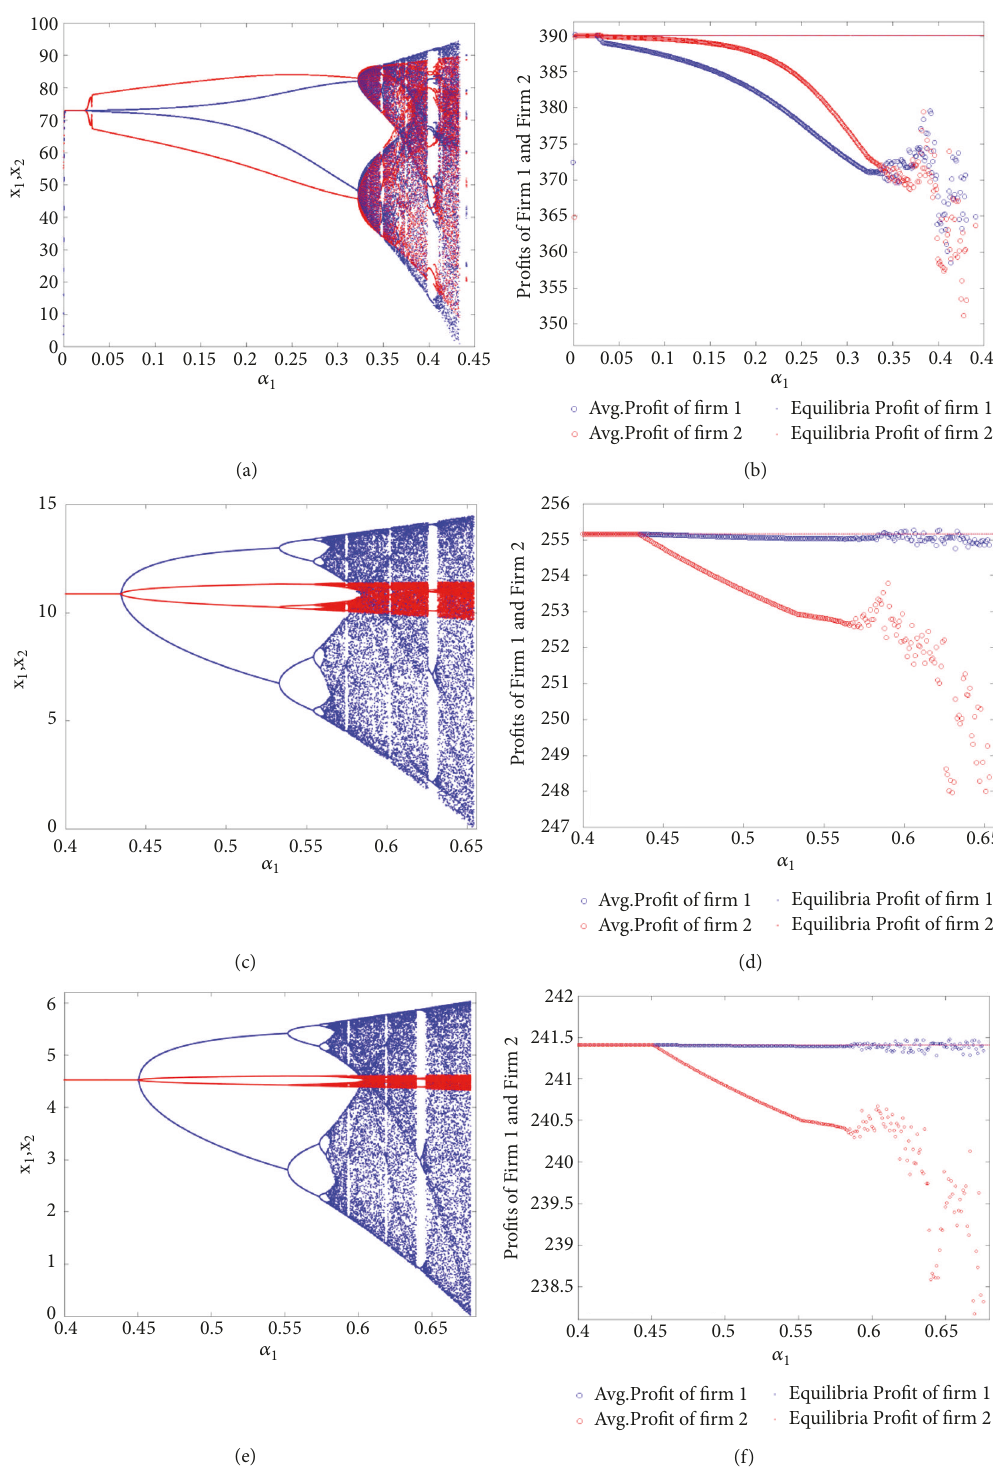
Figure 6: The one-parameter bifurcation diagrams, corresponding equilibrium profits, and average profits of firm 1 and firm 2 with fixed parametersas 𝑎 = 7.12 , 𝑏 = 0.024 , 𝑐 = 0.98 , 𝛽 = 0.38 , and 𝛼 2 = 0.345 ,wheretheblue colorcorresponds tofirm 1, while thered color represents that of firm 2. (a) The one-parameter bifurcation diagram when 𝛾 = 0.1 . (b) The equilibrium profits and average profits corresponding to (a). (c) The one-parameter bifurcation diagram when 𝛾 = 0.44 . (d) The equilibrium profits and average profits corresponding to (c). (e) The one-parameter bifurcation diagram when 𝛾 = 1.0 . (f) The equilibrium profits and average profits corresponding to